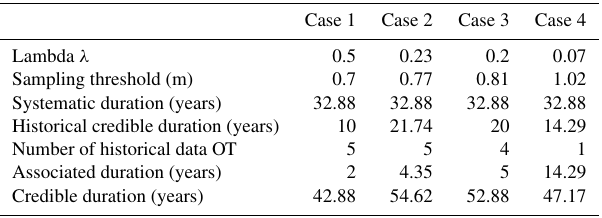
Table 1. Summary table of several variables involved in the computation of credible duration for 4 different cases of